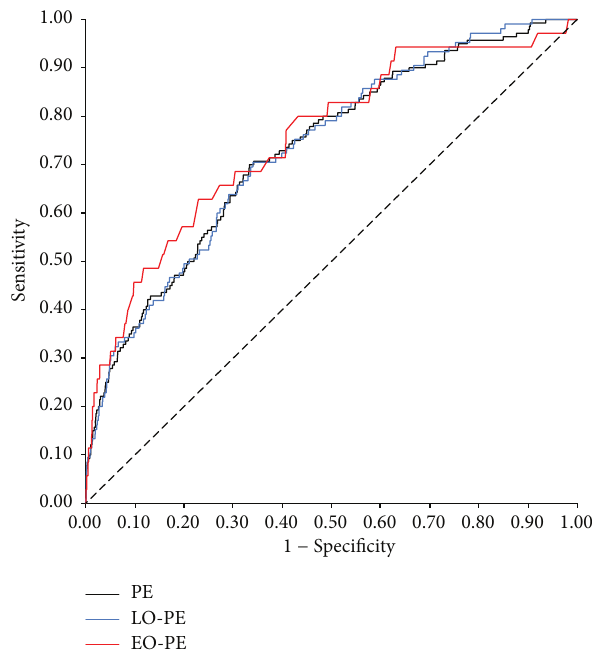
Figure 2: ROC curves of logistic regression models for prediction of PE, EO-PE, and LO-PE by maternal characteristics and aneu- ploidy screening biomarkers. PE, preeclampsia; EO-PE, early-onset preeclampsia; LO-PE, late-onset